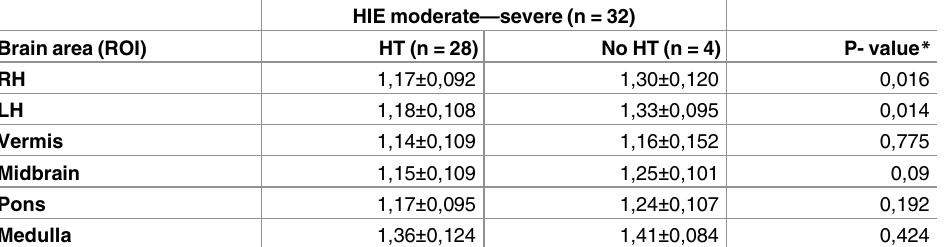
Table 3. The ADC mean (SD) x10 -3 /mm 2 /second at first MRI in six regions of interest (ROIs) in newborn with moderate and severeHIE with and without hypothermia.